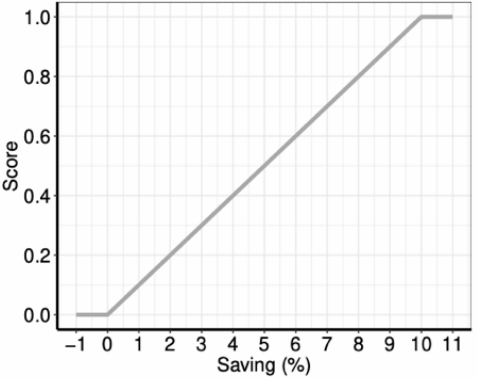
Figure A1. Utility function to calculate the contribution of adopting a technology or practice to a household’s motivations.